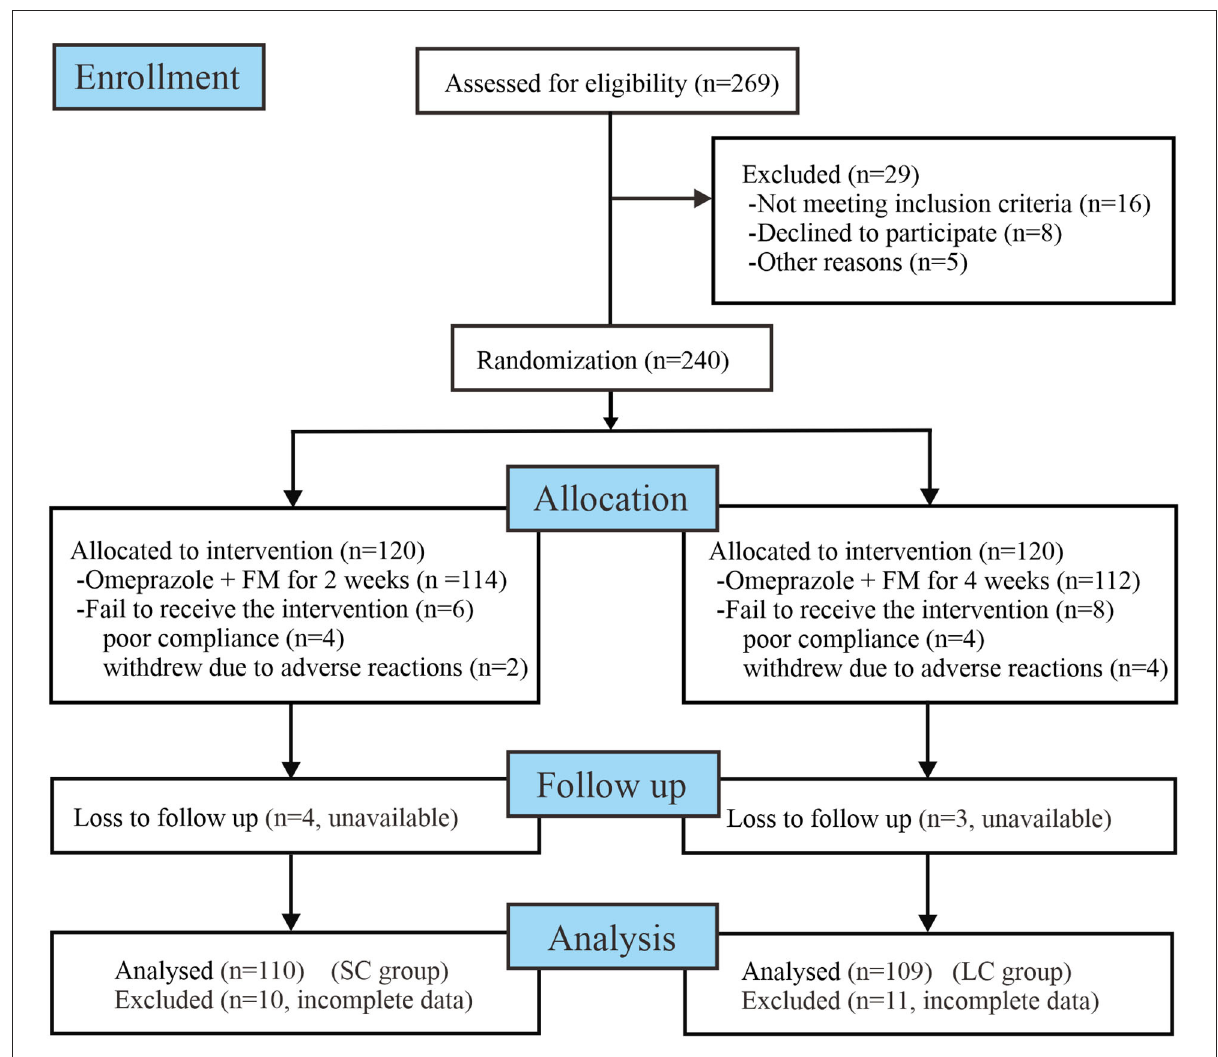
FIGURE1 Workflow of randomization and treatment procedures of enrolled patients. FM, flupentixol-melitracen; SC, short-course; LC, long-course.